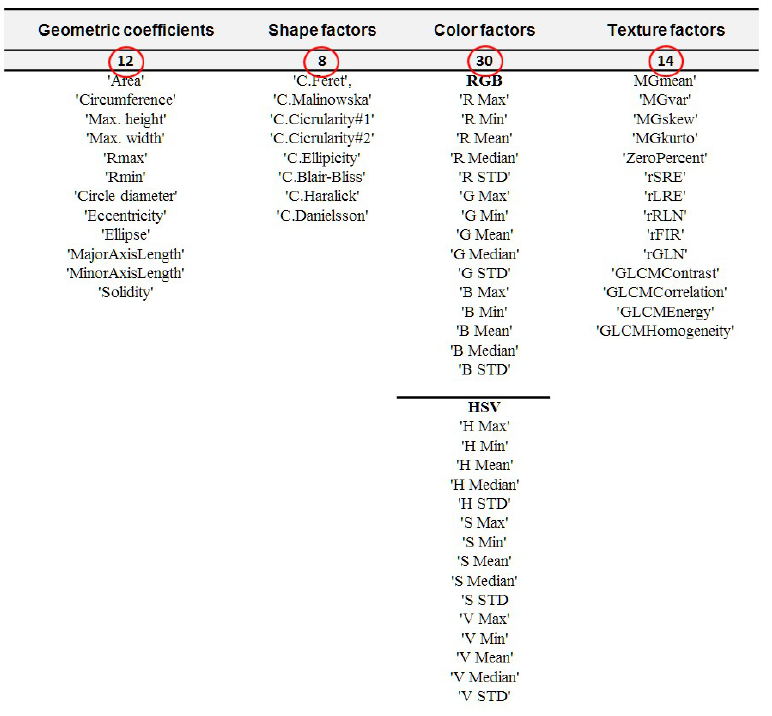
Figure 5. Specification of the barley varieties.